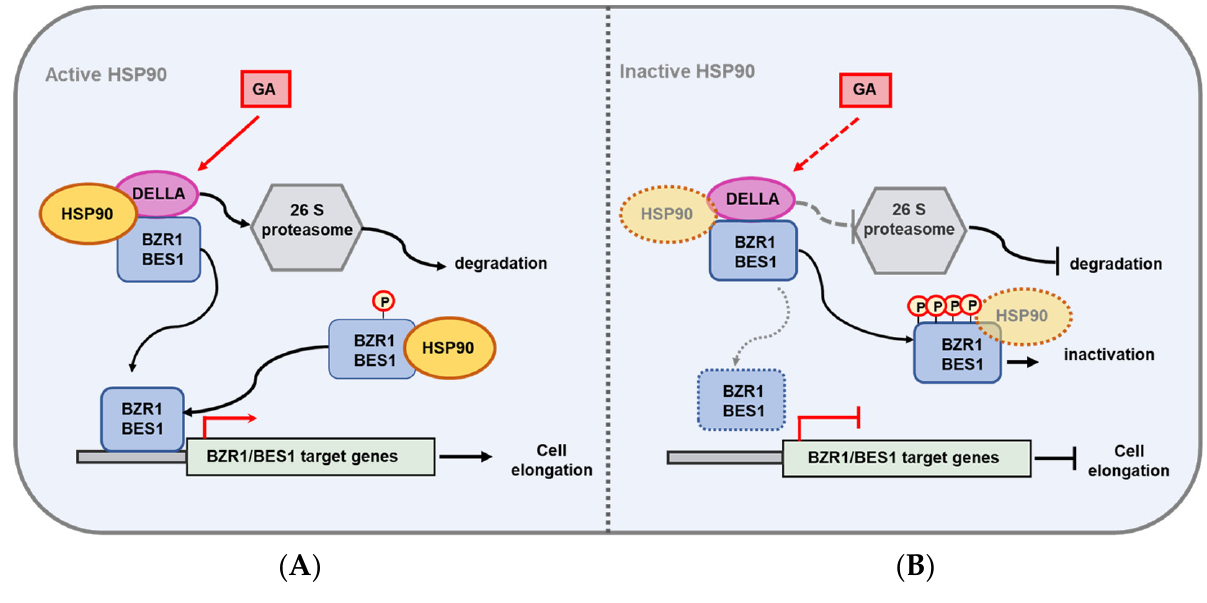
Figure 7. Schematic representation of the role of HSP90 in BL and GA crosstalk. The ATPase activity of HSP90 leads to degradation of DELLA proteins, allowing BR-dependent GA-promoted hypocotyl elongation and growth. ( A ) Active HSP90 interacts with partners of the BR signaling cascade, like BZR1/BES1 and of the GA signaling pathway, like DELLA proteins, controlling the phosphorylation state of BZR1/BES1 and facilitate the degradation of DELLA proteins to promote the expression of downstream transcriptional targets, which control the cell elongation of hypocotyl in the dark. ( B ) Inhibition of HSP90 function leads to aberrant BR and GA signaling caused by the accumulation of phosphorylated and inactivated BZR11/BES1 transcription factors, and the impaired degradation of DELLA proteins results in the arrest of hypocotyl elongation of etiolated seedlings. While the inhibition of HSP90 activity did not disrupt the formation of the RGA/BZR1 complex, it compromised GA-induced DELLA degradation and blocked BZR1-induced gene expression. Therefore, the inhibition of HSP90 ATPase activity could reinforce the RGA/BZR1 heterodimer formation (levels) in deregulated GA signaling and homeostasis. GA-induced DELLA degradation derepresses the attenuated BZR1 activity which in turn regulates the expression of its target genes